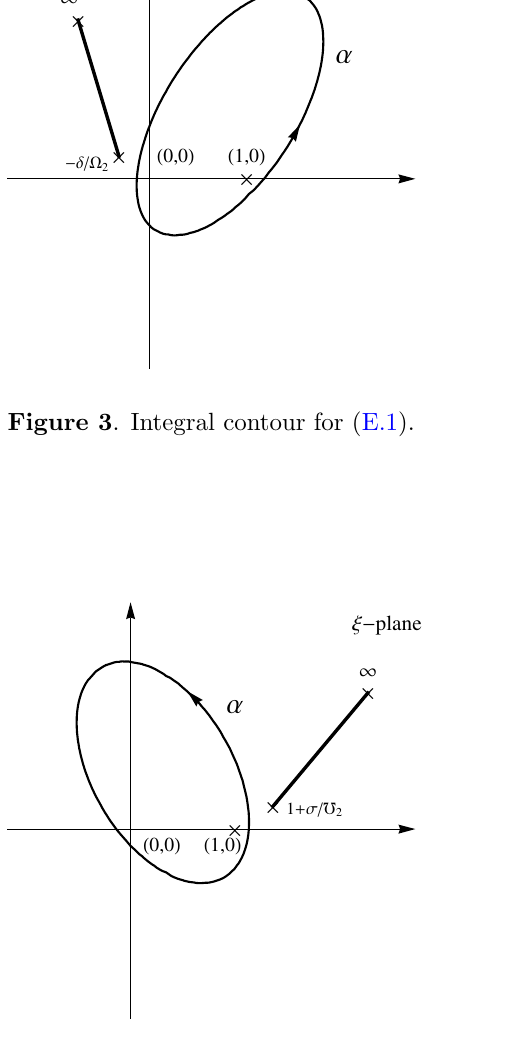
Figure 5 . Integral contour for (E.5). Figure 6 . Integral contour for